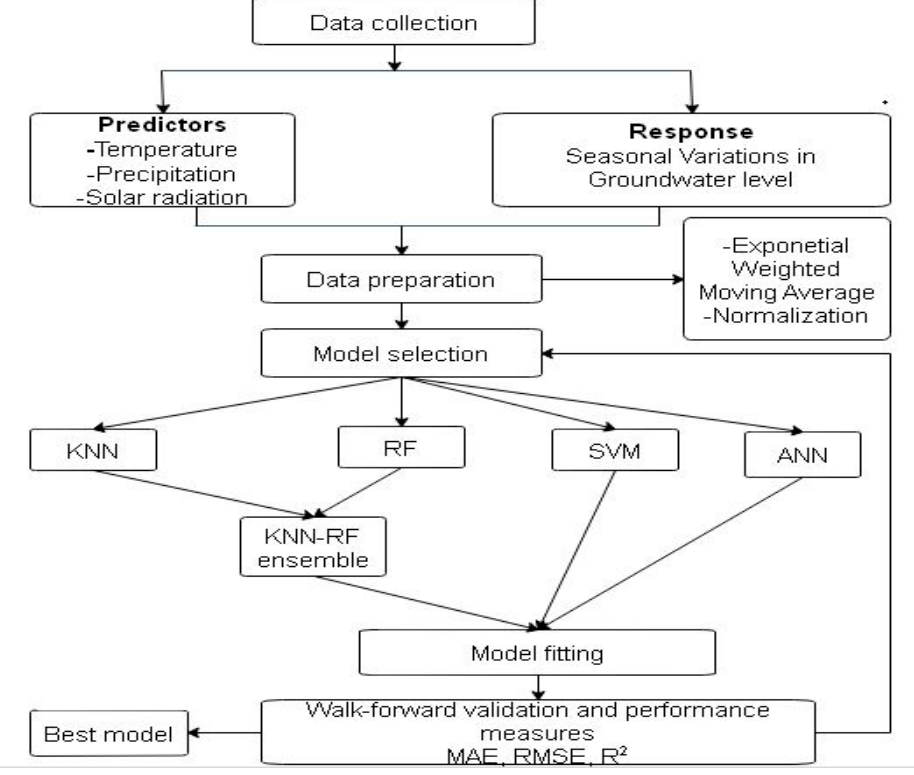
Figure 6. Flow chart of the KNN-RF method.